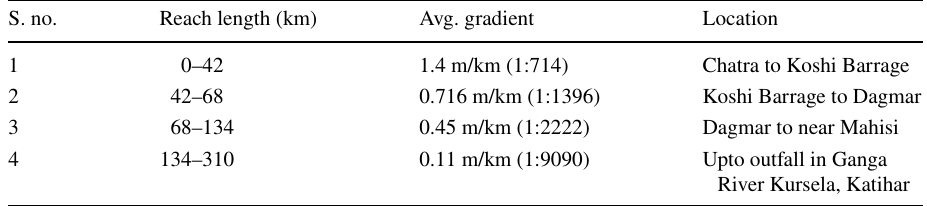
Table 3 Average bed gradient of Koshi